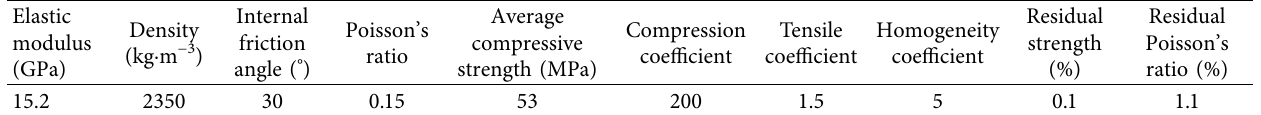
Table 7: Numerical model